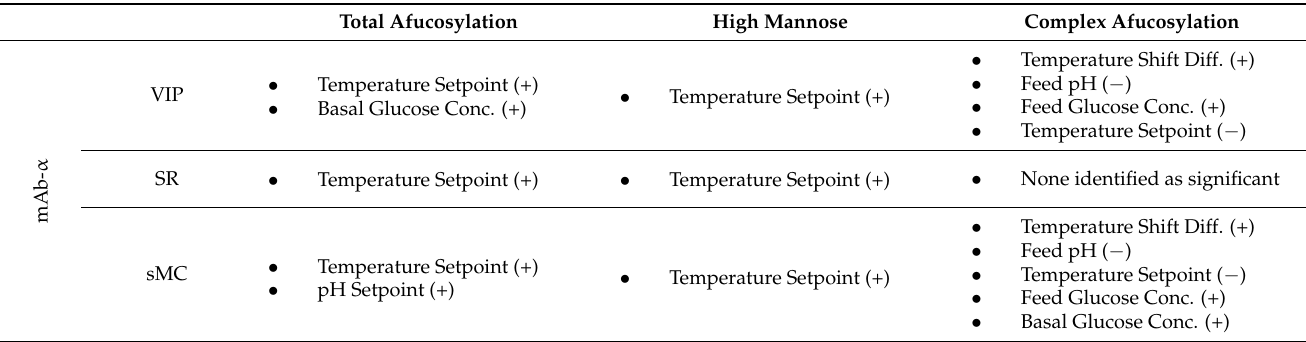
Table 2. The significant cell culture parameters influential to afucosylation identified by each of the PLSR model variable importance metrics. The parameters are organized in rank order of significance. The sign of the coefficient indicates either a positive (+) or negative ( − ) relationship between the parameter and